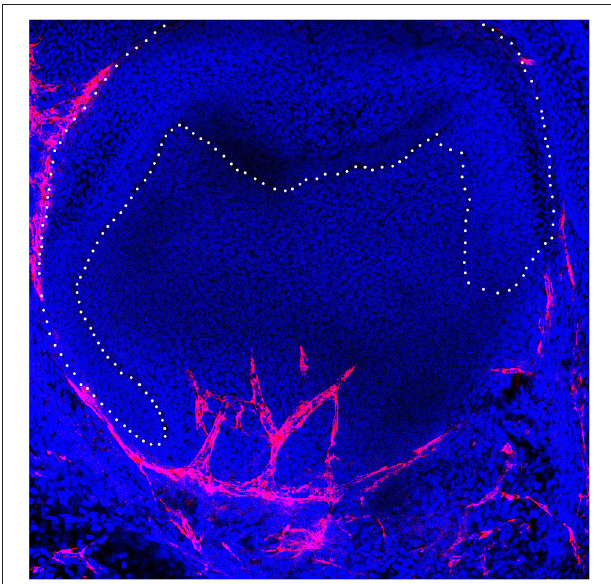
FIGURE 1 | Developing murine tooth germ with invading vasculature in red.